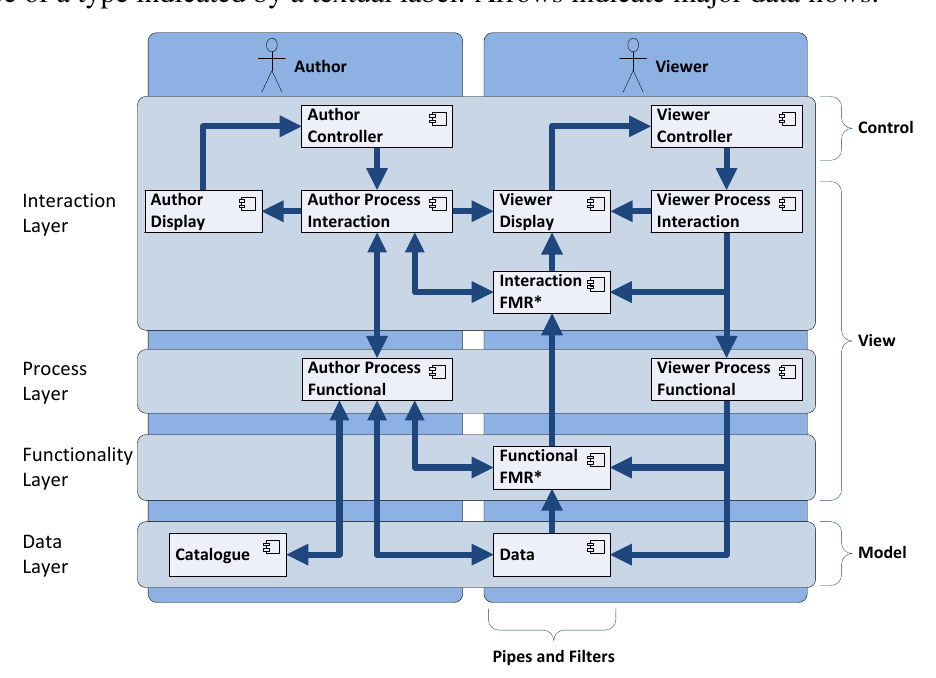
Component diagram relating SOA concepts, the interactive generalized visualization pipeline model and architectural patterns. Each component represents a service instance of a type indicated by a textual label. Arrows indicate major data